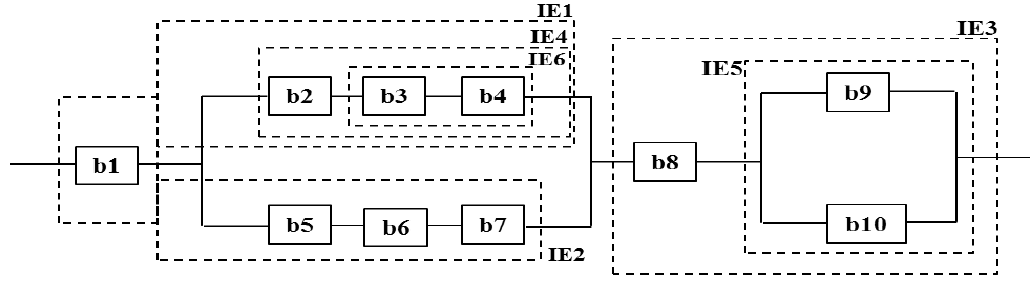
Figure 7. Equivalent RBD for HV phase R bushing explosion.